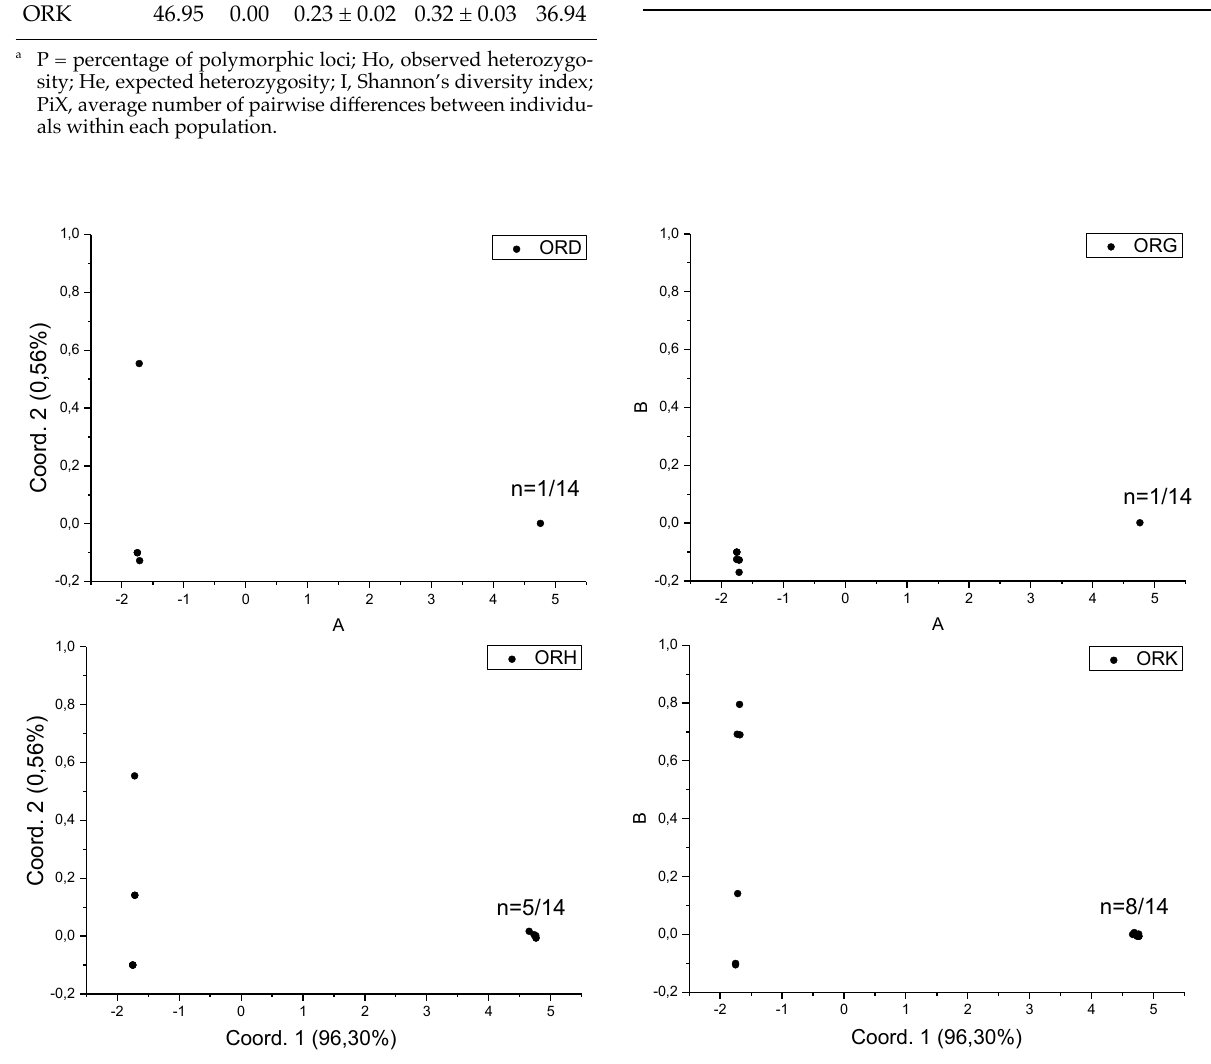
Figure 3. Principal coordinates analysis of four sunflower broomrape populations (ORD, ORH, ORG, ORK) collected in Tunisia. The analysis was carried out for the four populations together, but they are represented in separate